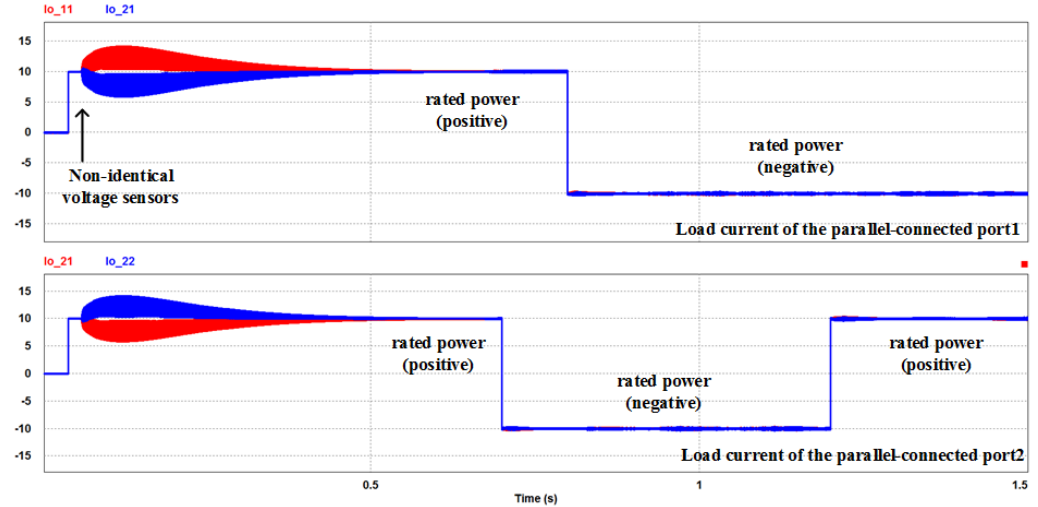
Figure 13. Simulation waveform to verify the current sharing controller.